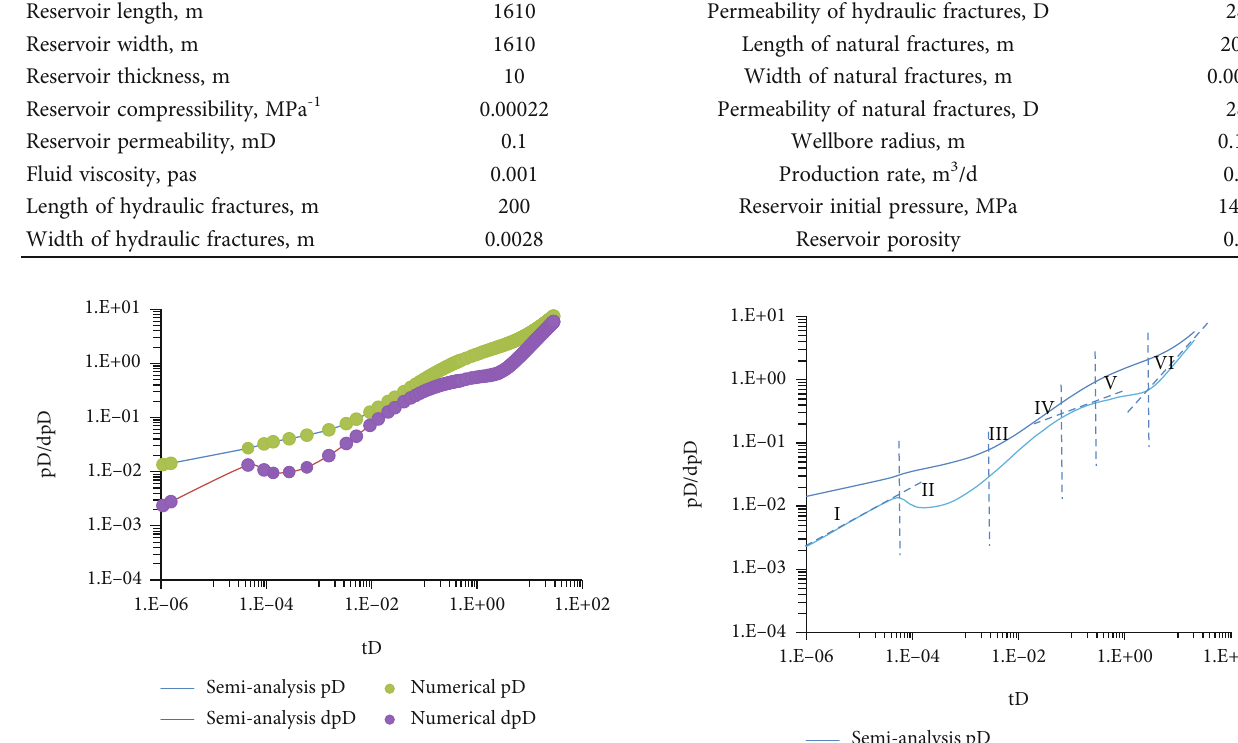
Figure 5: Comparison of the semianalytic model and numerical results.